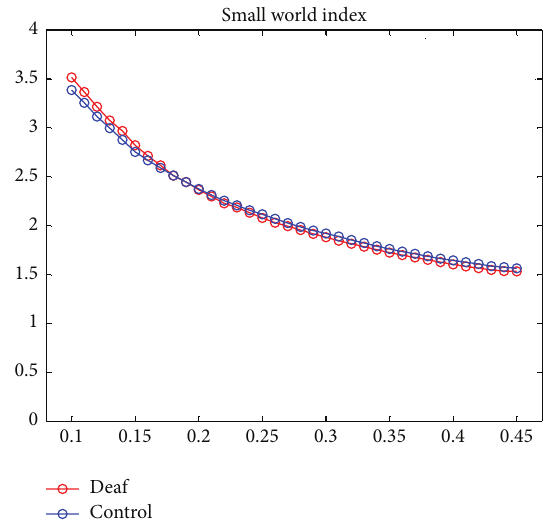
Figure 4: Small world index 𝜎 across sparsities from 10% to 45% with an interval of 1% in prelingually deaf adolescents (red color) and normal controls (blue color). Both of the two groups present the property of small-worldness since 𝜎 ≫